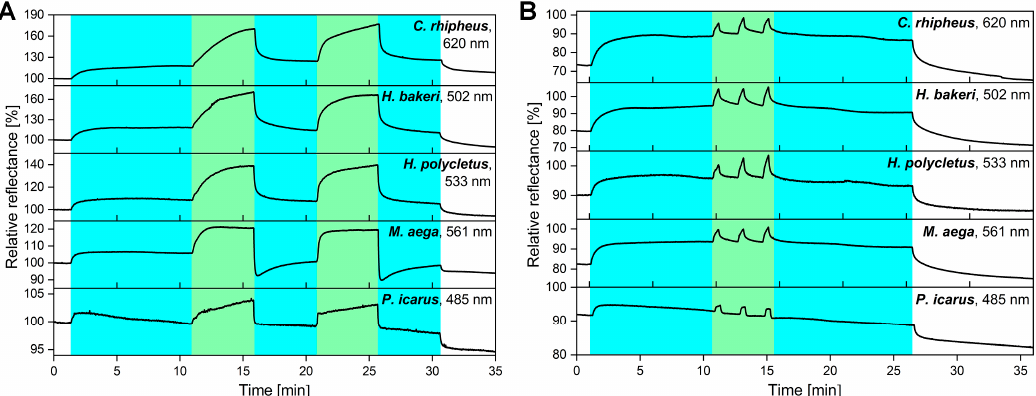
Figure 6. The VOC-sensing properties of the samples were tested in the presence of humidity. Therefore, a constant 25% water vapor background was applied, and it was followed by ( A ) two 5-min-long 50% ethanol vapor exposures or ( B ) three 30 s 50% ethanol pulses. In both cases, the response signal was separated from the background of the humidity, and the intensity of the time-dependent signal was preserved compared to the humidity-free case (Figure 3). The nanometer values in the top right corners show the wavelength of the maximal spectral responses from which the time-dependent signals were generated.